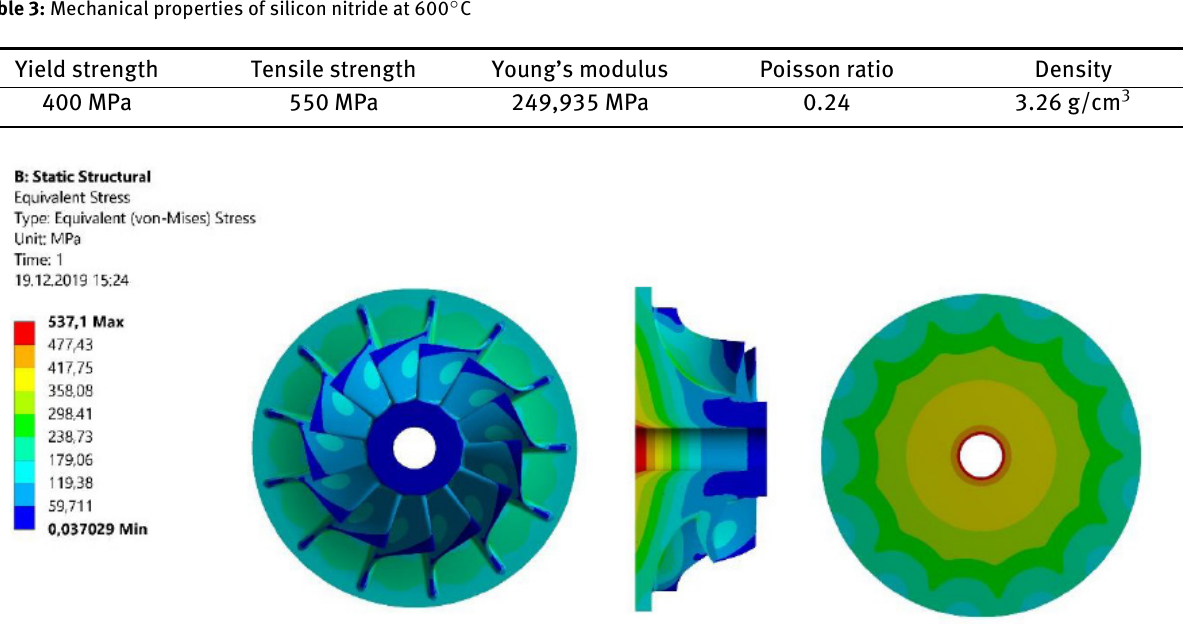
Figure 26: Front, side and rear view of turbine disc – base ceramic with reduced stress distribution (rotational speed – 96,000 rpm; temper- ature – 600 ∘ C)